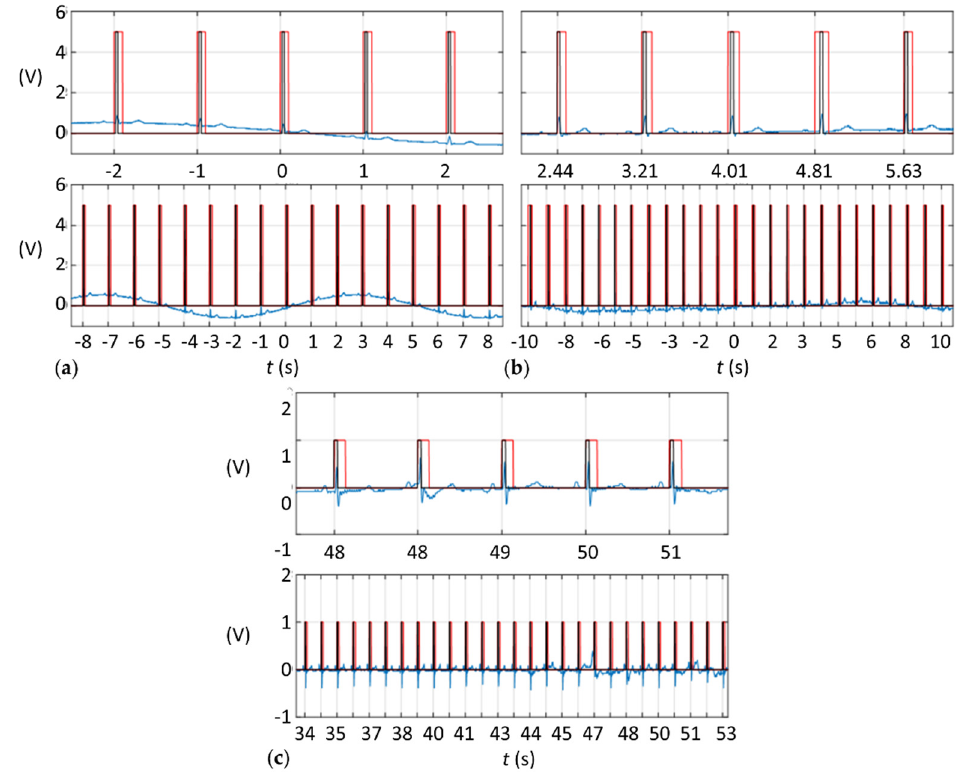
Figure 6. ECG (blue), TTL (red), and ideal TTL (black) signals ( a ) when adding a sinusoidal wave to the demonstration ECG signal; ( b ) when using the ECG from a moving human patient; and ( c ) when using the ECG from an anesthetized swine specimen. Note that comparisons on the TTL signals should be made on the raised edge of the